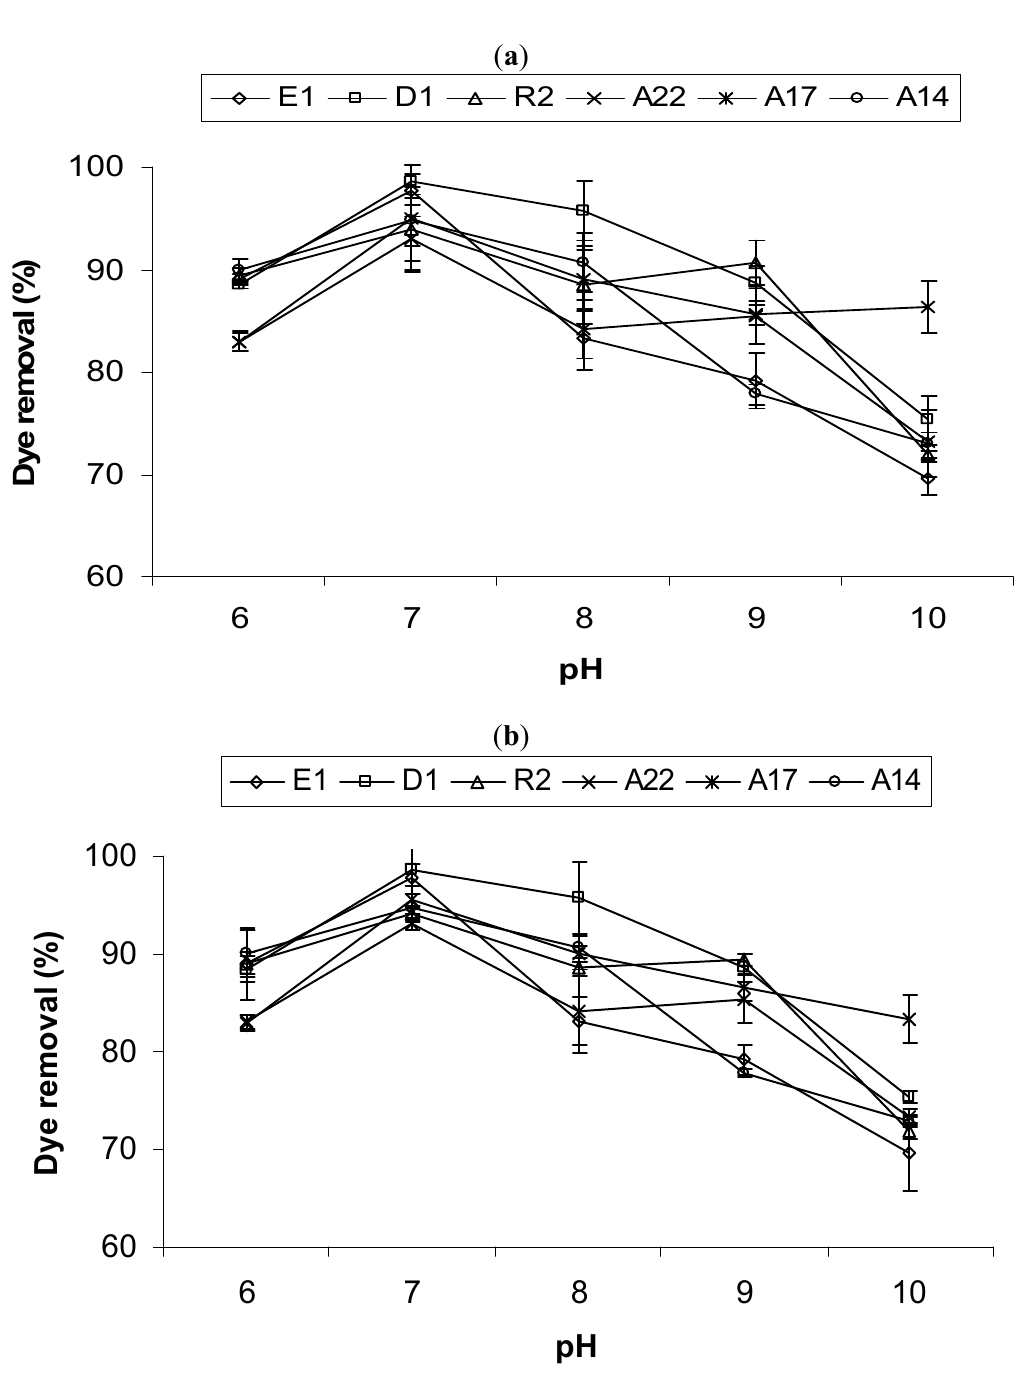
Figure 2. Effects of pH on the removal of ( a ) whale dye; ( b ) mediblue dye; ( c ) fawn dye; and ( d ) mixed dye from textile industrial